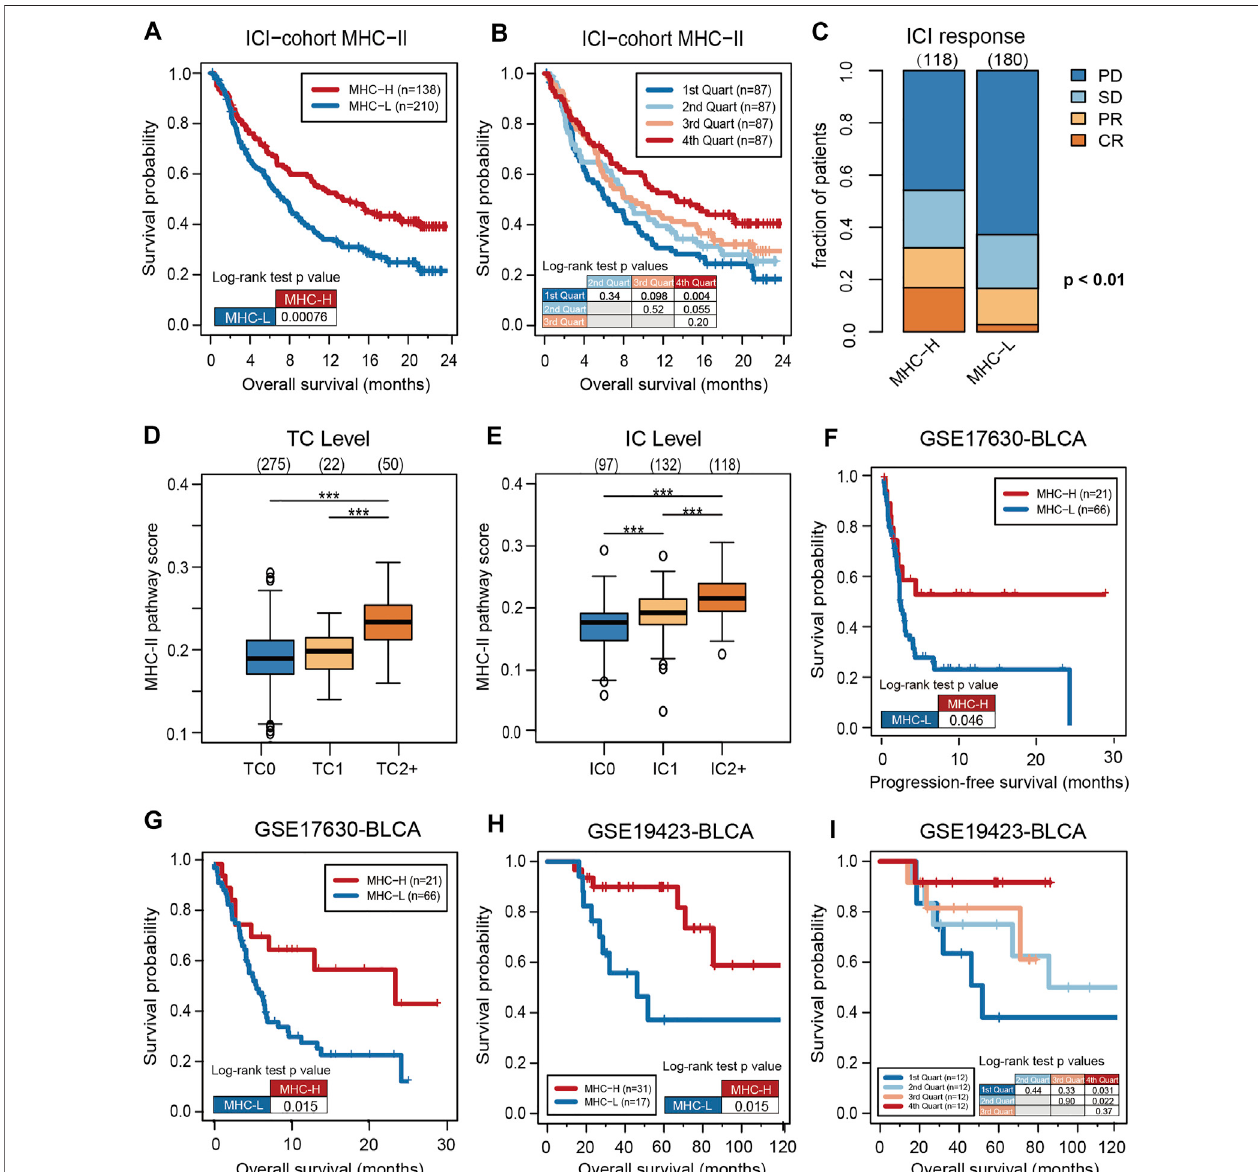
FIGURE 2 | High MHC-II signature predicts the favorable prognosis and immune response of ICIs. (A) The KM analysis was performed on MHC-H ( n = 138) and MHC-L( n =210)groupsintheICI-cohort.Theoverallsurvival(OS)oftheMHC-Hgroupwassigni fi cantlylongerthanthatofMHC-Lgroup(hazardratio[HR]=0.63,95% con fi denceinterval[CI]:0.49 – 0.82,logranktestP=7.60e-04). (B) MHC-IIsignaturequartileswerealsosigni fi cantlyassociatedwithOS. (C) MHC-IIsignaturewashighly correlatedwith immune response, particularly withcomplete response (CR) (two sidedFisher ’ sexacttest, P < 0.01; n =298; Theresponsestatusof50cases was not reported). PD, progressive disease; SD, stable disease; PR, partial response. (D,E) MHC-II signature was highly correlated with the expression of PD-L1, including TC levels (D) and IC levels (E) (all P < 0.001). Tumor tissue samples were scored via immunohistochemistry (IHC) for PDL1 expression on tumor cells (TC) and tumor- in fi ltrating immune cells (IC), respectively. Specimens were scored as IHC TC0, TC1, TC2, or TC3 if < 1%, ≥ 1% but < 5%, ≥ 5% but < 50%, or ≥ 50% of TC were PD-L1 positive, respectively. Specimens were scored as IHC IC0, IC1, IC2, or IC3 if < 1%, ≥ 1% but < 5%, ≥ 5% but < 10%, or ≥ 10% of IC were PD-L1 positive, respectively. Tumor-in fi ltrating immune cells included macrophages, dendritic cells and lymphocytes. *P < 0.05, **P < 0.01, ***P < 0.001, and ****P < 0.0001, ns, not signi fi cant. (F) Validation ofthe GSE17630 − BLCA cohort ( n = 87) treated with ICIsshowedthat the PFS ofthe MHC-H group was signi fi cantlylonger than that ofthe MHC-L group (HR = 0.50, 95% CI: 0.28 – 0.89, log rank test P = 0.046). (G) . Validation of the GSE17630 − BLCA cohort ( n = 87) treated with ICIs showed that the OS of the MHC-H group was signi fi cantlylongerthanthatoftheMHC-Lgroup(HR=0.43,95%CI:0.24 – 0.76,logranktestP=0.015). (H) ValidationoftheGSE19423-BLCAcohort( n =48)treatedwith ICIsshowedthattheOSoftheMHC-Hgroupwassigni fi cantlylongerthanthatoftheMHC-Lgroup(HR=0.32,95%CI:0.11 – 0.94,logranktestP=0.015). (I) Validationof the GSE19423-BLCA cohort treated with ICIs showed that MHC-II signature quartiles were also signi fi cantly correlated with OS.